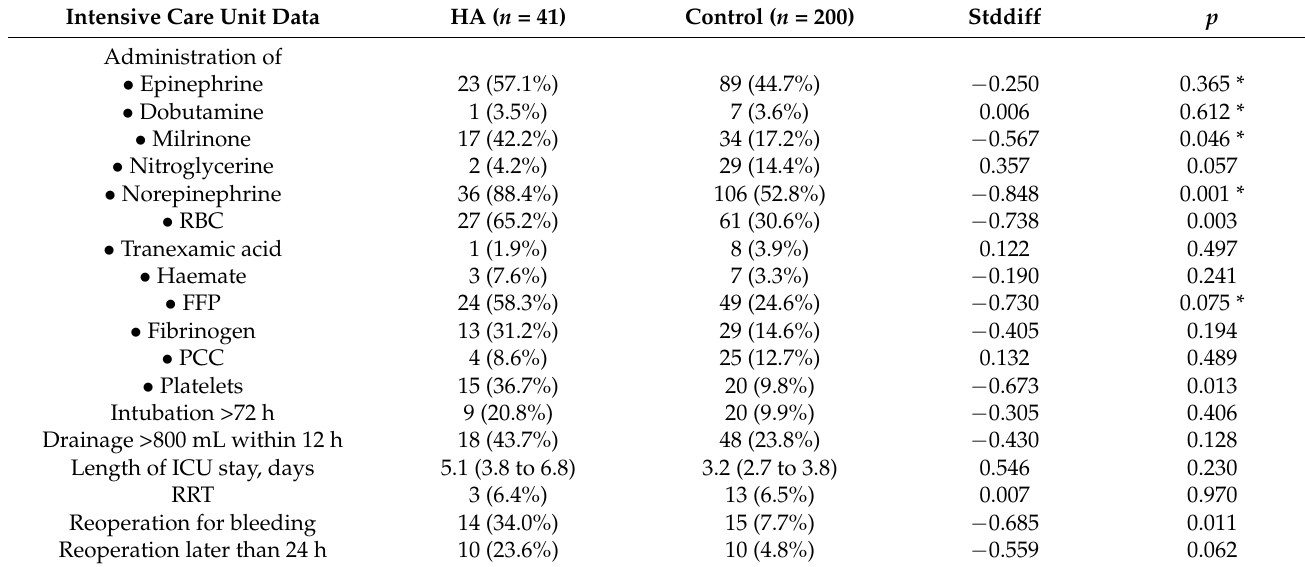
Table 3. Intensive care unit (ICU) data after inverse probability of treatment weighting.